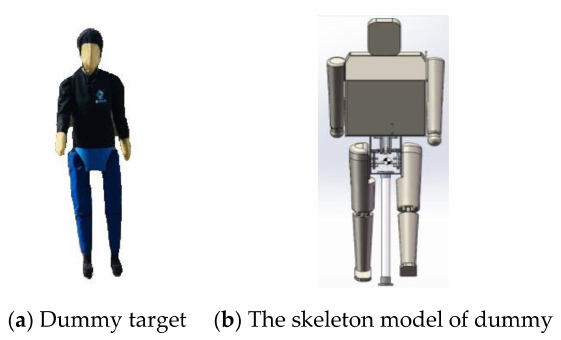
Figure 3. Dummy target for simulating pedestrian.